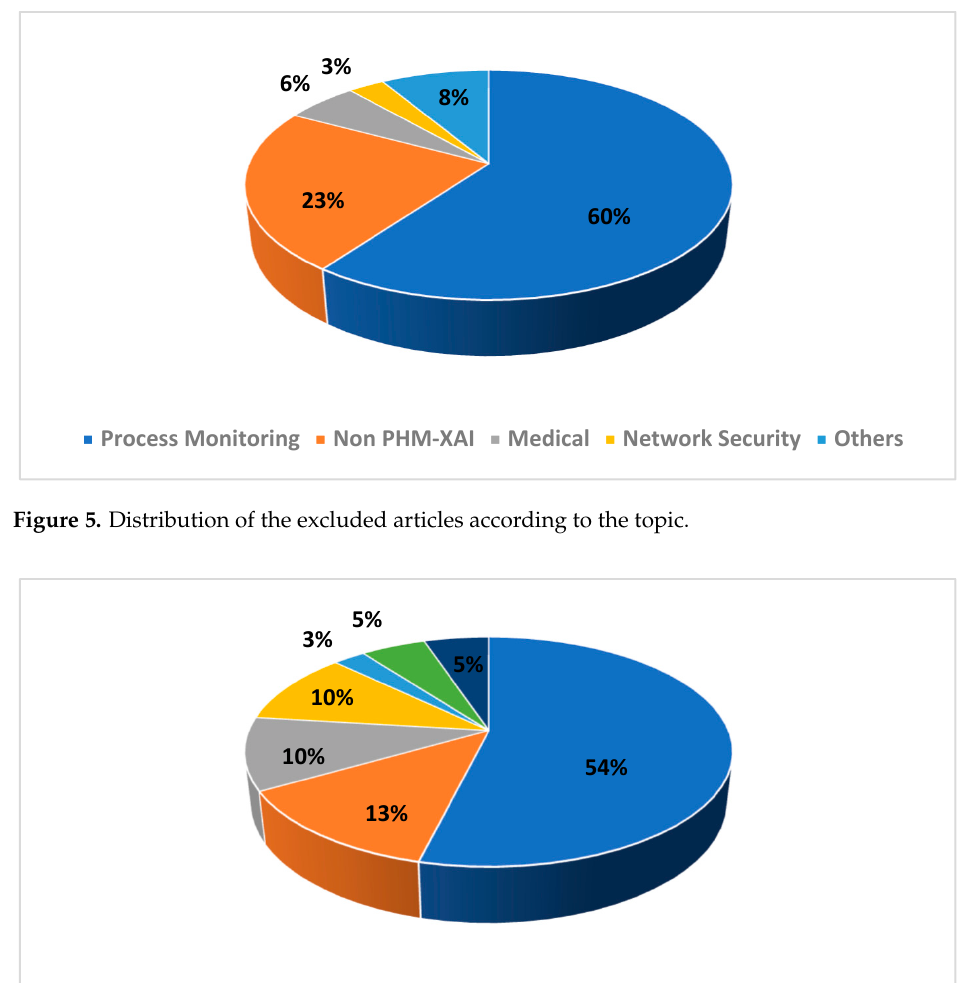
Figure 4. Distribution of the selected articles according to the indicated publisher.